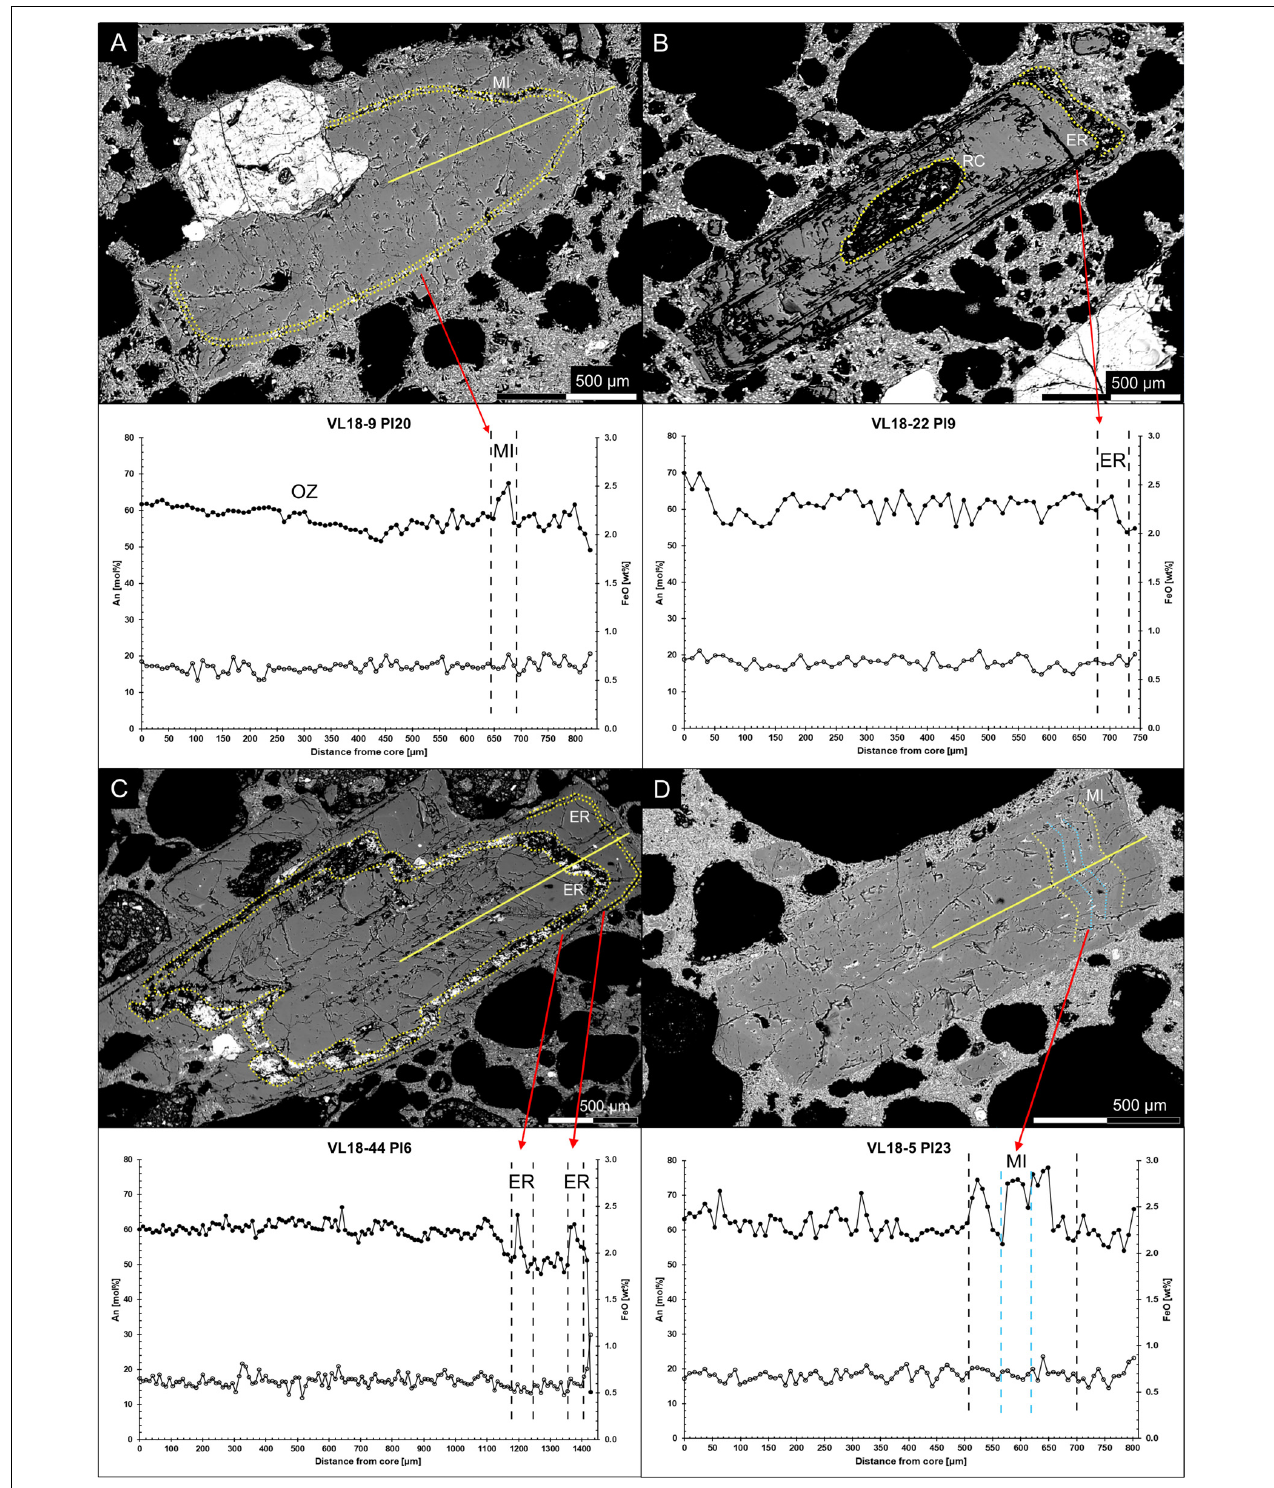
FIGURE 7 | High-contrast and back-scattered images of some representative plagioclase crystals, together with their core-to-rim EMPA/WDS profiles (steps of 5–10 µ m). (A) Oscillatory zoned (OZ) plagioclase with Melt Inclusion Layers (MIL): in correspondence of the inclusions a peak of ∼ (cid:49) An 10 is registered, at fairly constant FeO. (B) Plagioclase showing a Totally Resorbed Core (TRC) and Enveloped Rims (ER) textures. (C) Mildly resorbed Plagioclase crystals (MRC) with a coarsely sieved core, characterized by two layers of ER. (D) Plagioclase crystal with three layers of melt inclusions toward the rim of the crystal.